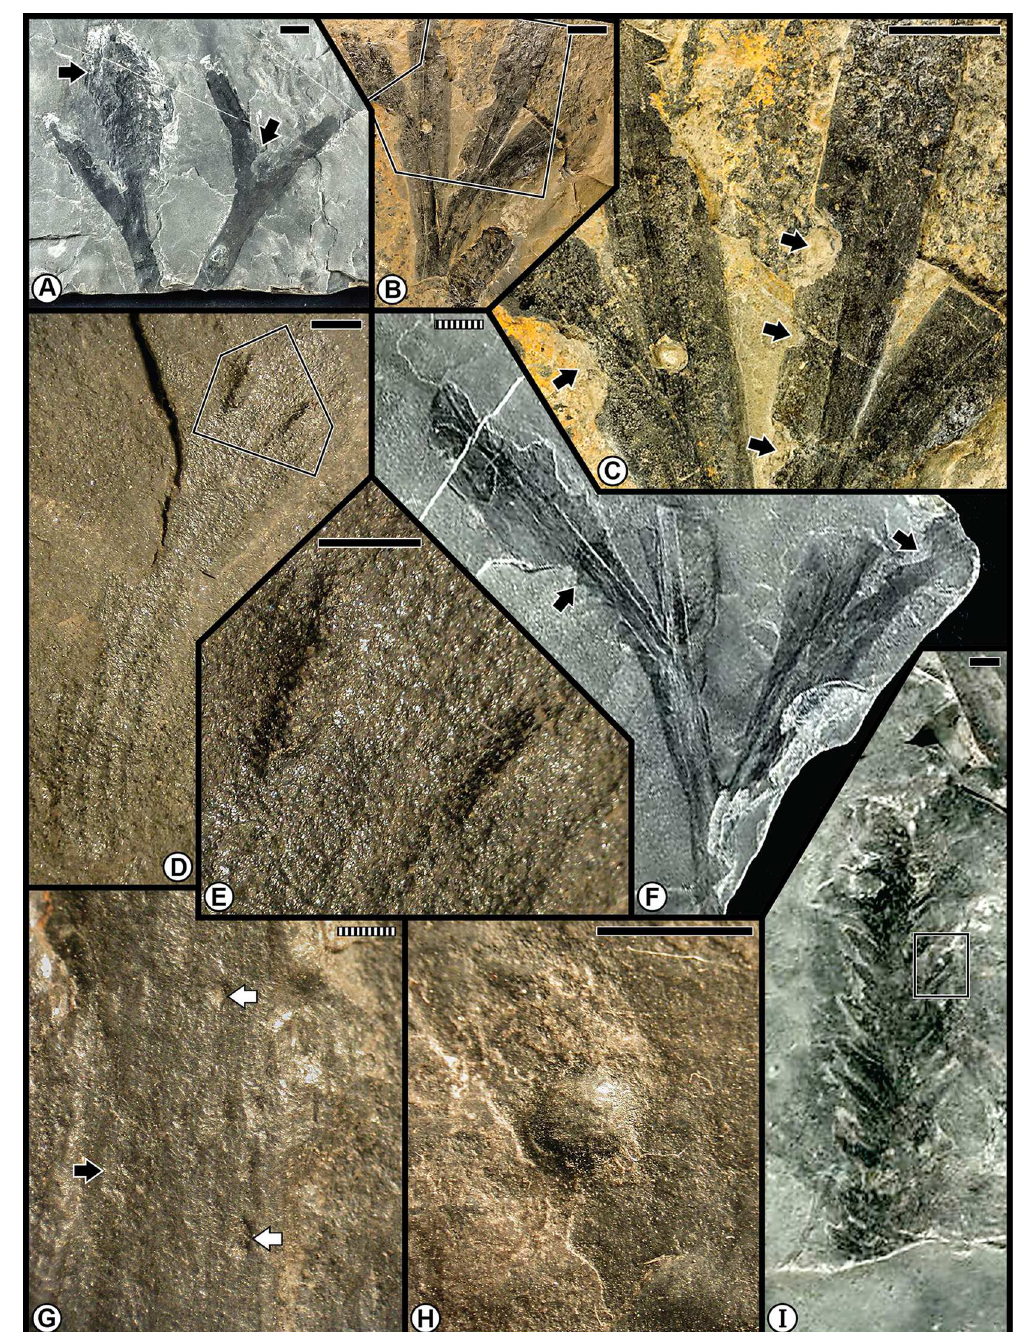
Fig 4. Plant–insect interactions from the Cisuralian (Kungurian) Tregiovo Flora, of the Tregiovo Formation near Tregiovo in northeastern Italy. A : Undetermined pteridosperm, with margin feeding(DT12) indicatedby the white arrow at right, and a large stem gall (DT87) by the black arrow at left. SpecimenMUSE PAG-7352. B : Undetermined pteridospermwith margin feeding (DT12). Specimen MUSE PAG-7094. C : Enlargedspecimen from template at (B) showingseveral examples of margin feeding(DT12), four of which are indicated by black arrows. D : Unknown axis with two examplesof stem oviposition (DT76). Specimen MUSE PAG-7176. E : Enlarged oviposition-mark scars indicatedby template at (D). F : Undetermined pteridosperm showingexamplesof margin feeding (DT12), two of which are indicatedby black arrows. Specimen MUSE PAG-7383. G : Foliage of the conifer Quadrocladus sp., showingexamplesof DT12 at left (black arrow) and piercing-and-sucking damage of DT46 and DT47 at right (white arrows). Specimen MUSE PAG-7116. I : Undetermined conifer with foliage gall